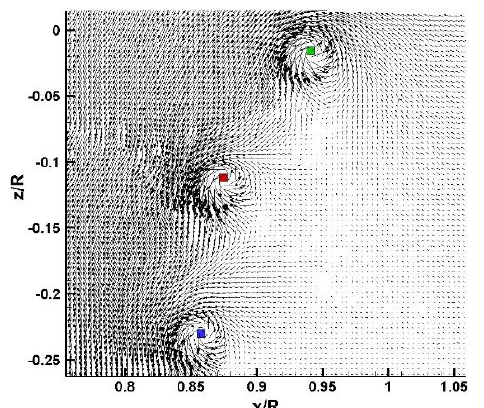
z/R = −0.97 Figure 9. PIV vs. numerical vertical velocity comparison.